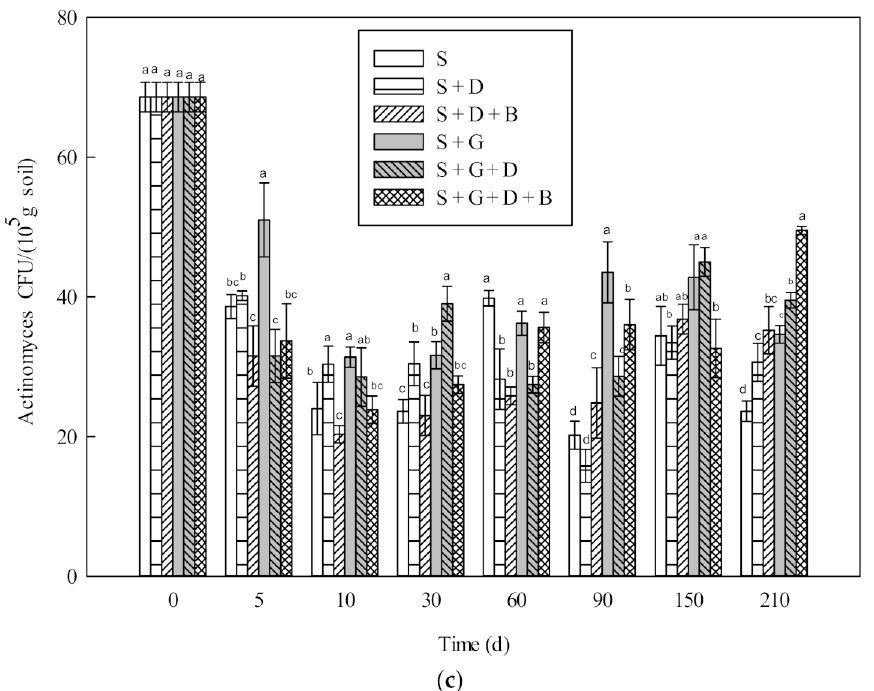
Figure 2. Change of microbial quantity in the soil during the bioremediation process. The error bar indicates standard deviation; the letters (a, b and c) in columns indicate significant differences at p < 0.05 level among 6 treatments at the same times. ( a ) bacteria; ( b ) fungi; ( c ) actinomycetes.